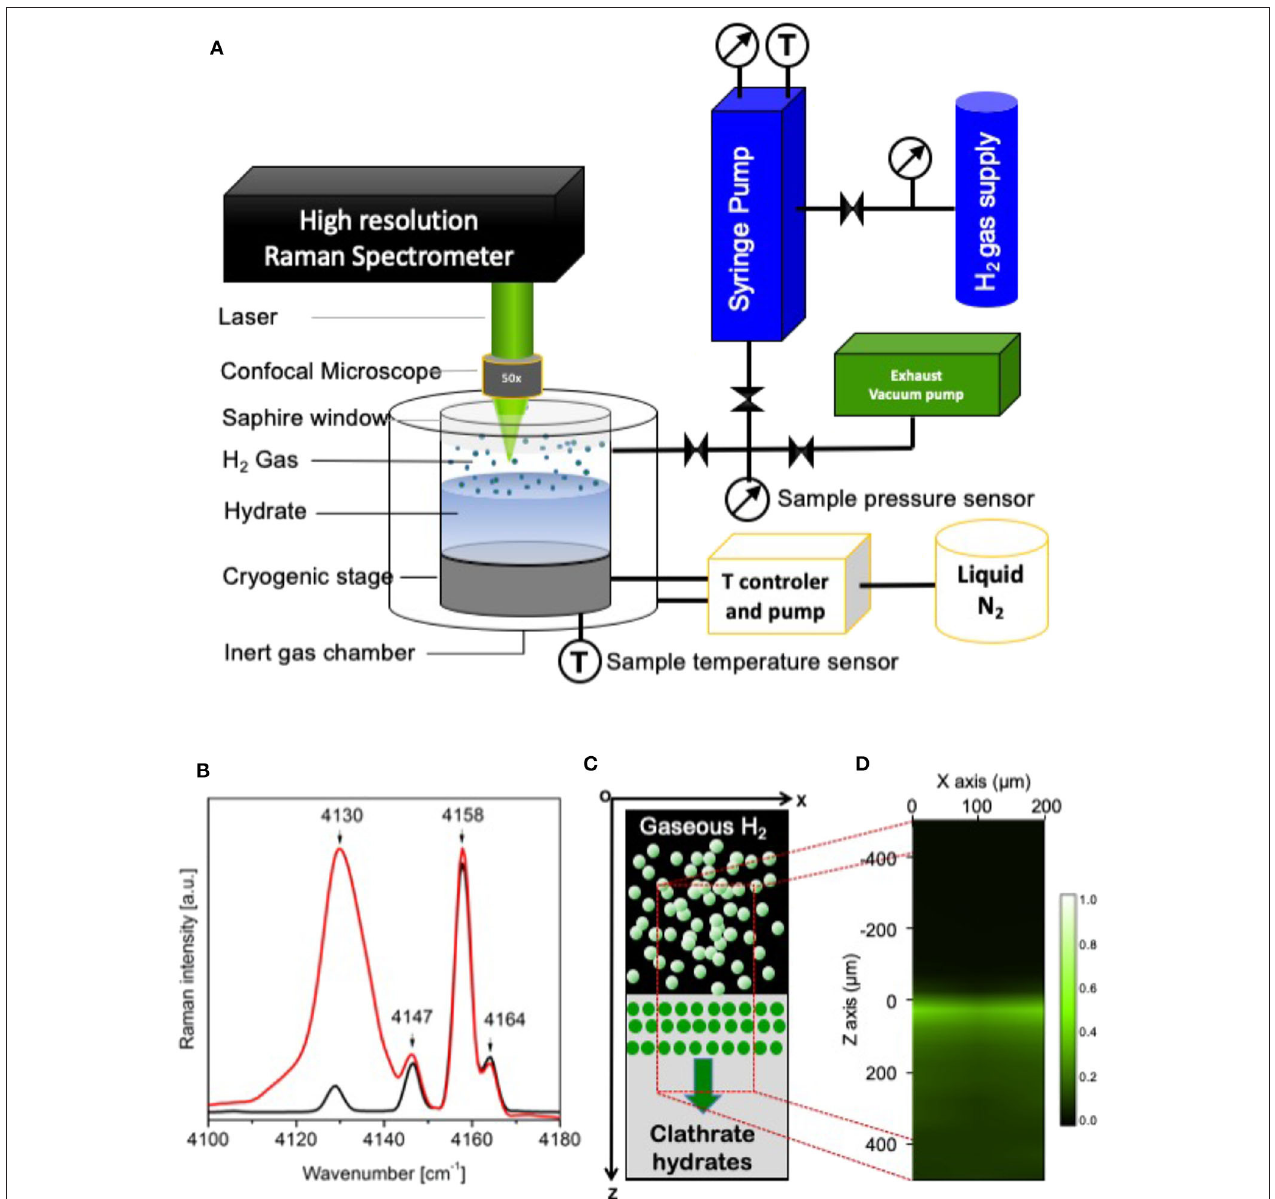
FIGURE 1 | (A) Schematic representation of the experimental set-up used to monitor the insertion of molecular hydrogen within the THF hydrate. (B) Raman spectra of H 2 gaseous (black, A ) and of confined H 2 in THF hydrate (red, A ) at 270K and 200 bar; (C) Schematic illustration of experimental measurement. The microraman imaged region is shown with red dashed lines; (D) Spectral image constructed using the integrated intensities of Raman bands at 4,130 cm − 1 (encapsulated H 2 ). Green color indicates inserted H 2 in the hydrate and black color indicates no H 2